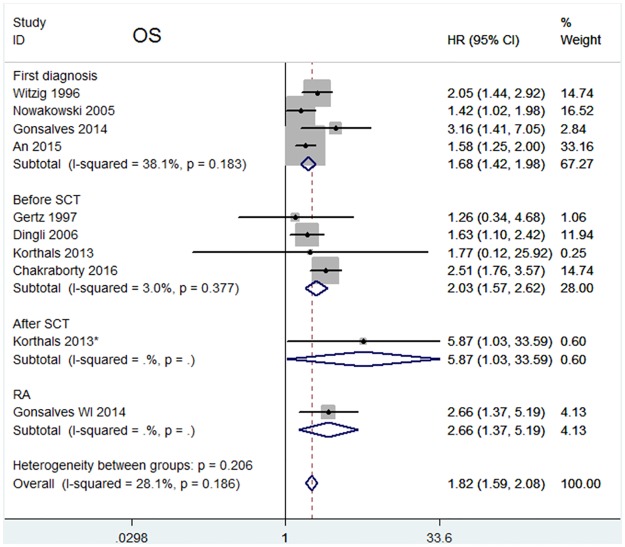
Forest plot of HRs and 95%CIs for OS.Subgroup analysis was according to different sampling time: four studies assessed CPCs at first diagnosis; four studies assessed CPCs before SCT. HR higher than 1 indicate that the presence of CPCs is associated with worse prognosis.